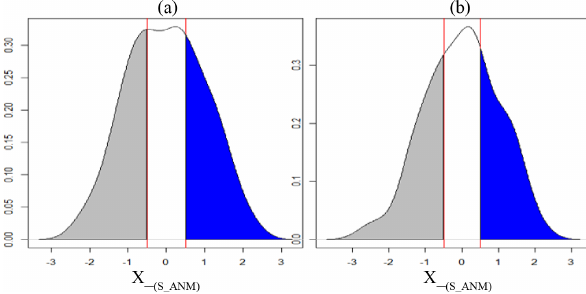
Figure A2. (a) Norton Bridge SWM rainfall anomaly distribution;